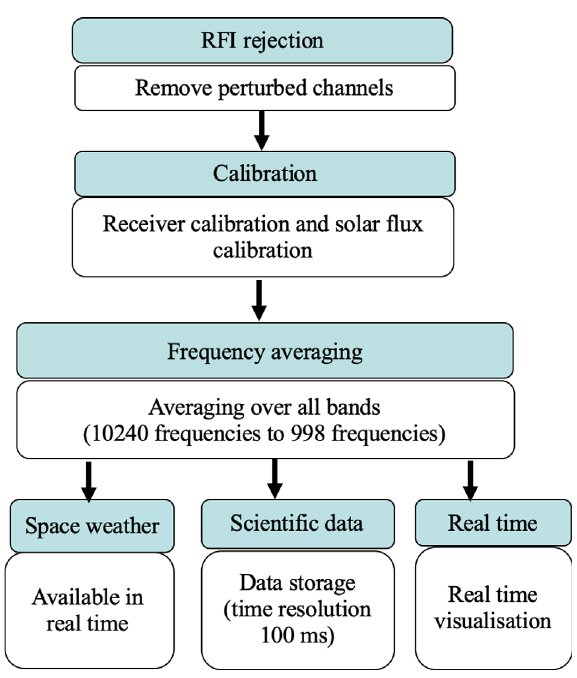
Fig. 4. Organizational chart summarising data processing in the ORFEES data acquisition